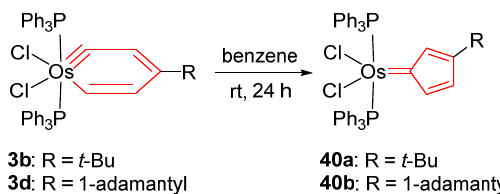
Scheme 8. Substituent effect on migratory insertion reaction.